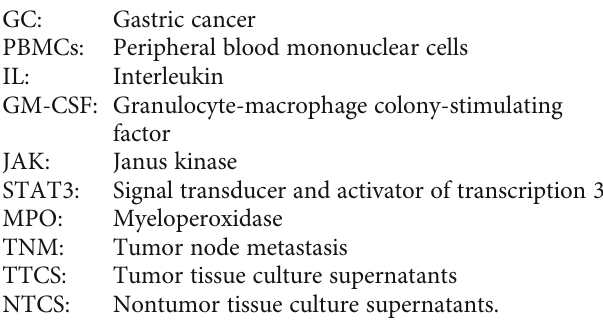
Supplementary 1 . Supplementary Figure 1: MPO expression and its potential correlations with clinical parameters. MPO expression in GC tumors was analyzed for correla-